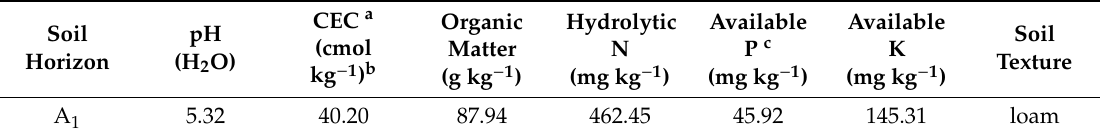
Table 1. Selected properties of the A 1 horizon of Haplic Cambisols used in the experiment (mean, n c =